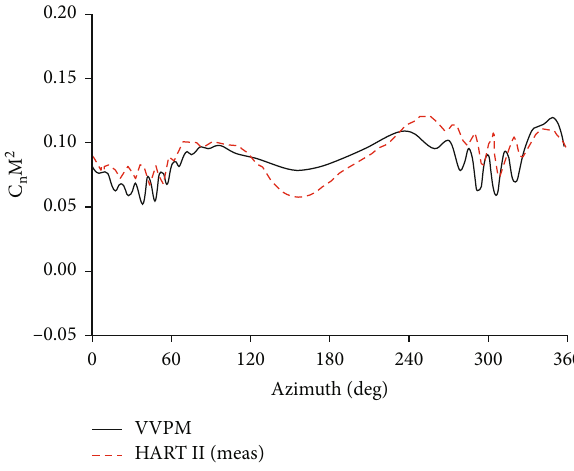
M 2 ) predictions at 87% radial n